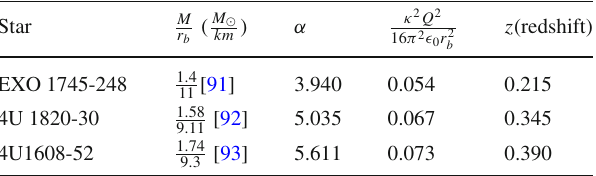
Table 1 The dimensionless parameter α , the dimensionless charge- radius ratio κ 2 Q 2 and the surface redshift z obtained by using the 16 π 2 (cid:4) 0 r 2 b observational mass M and the radius r b for some neutron stars with ω = 0 . 2 and k =